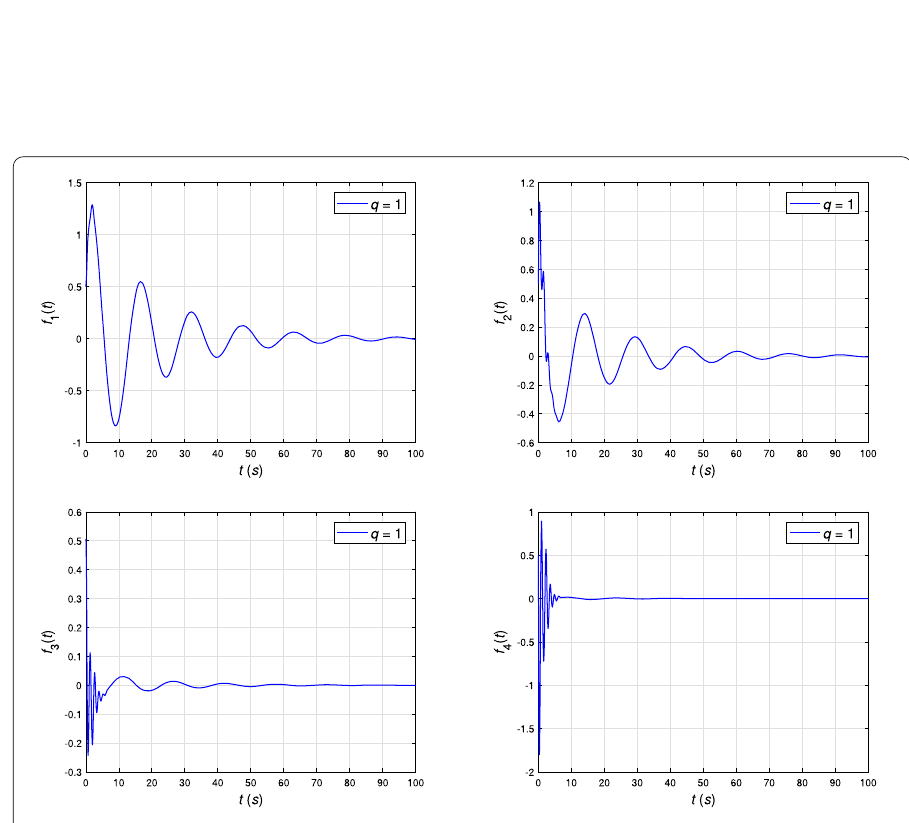
Figure 12 The time-domain responses of the controlled system (14) for q =